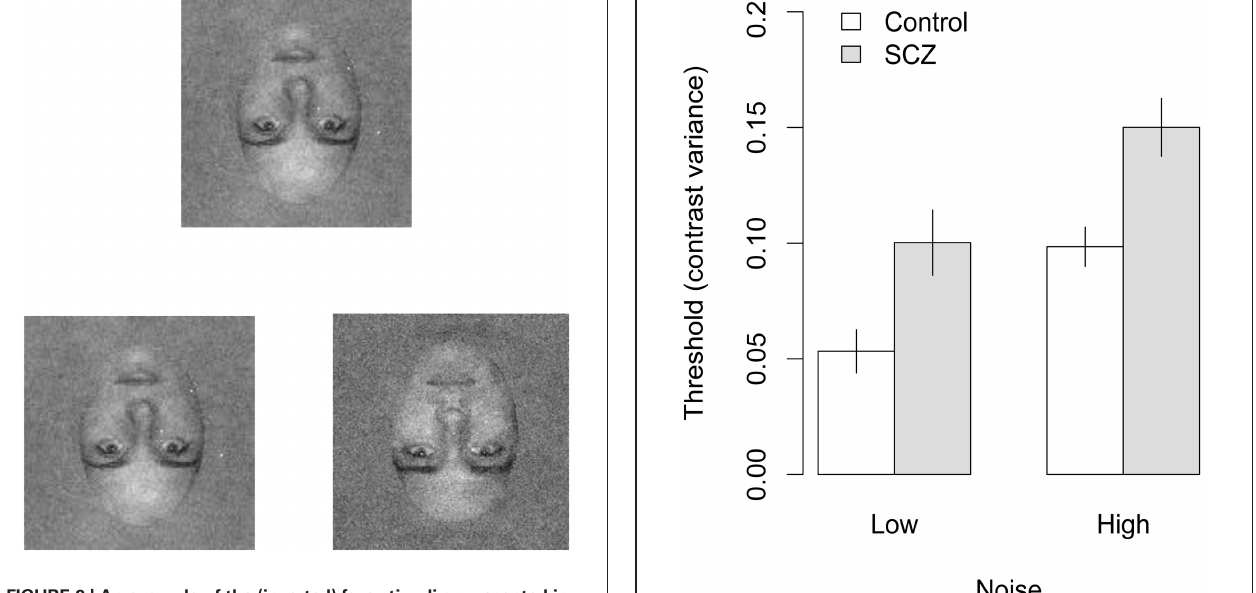
FIGURE 3 | An example of the (inverted) face stimuli as presented in the current experiment. The inverted face is shown in both low (left) and high (right) external noise conditions. Participants were shown a target face (top) that was presented without noise. Following an inter-stimulus interval of 200ms in which a static mask was presented, a pair of test faces consisting of the target and a distractor appeared. Participants were asked to discriminate the target face.